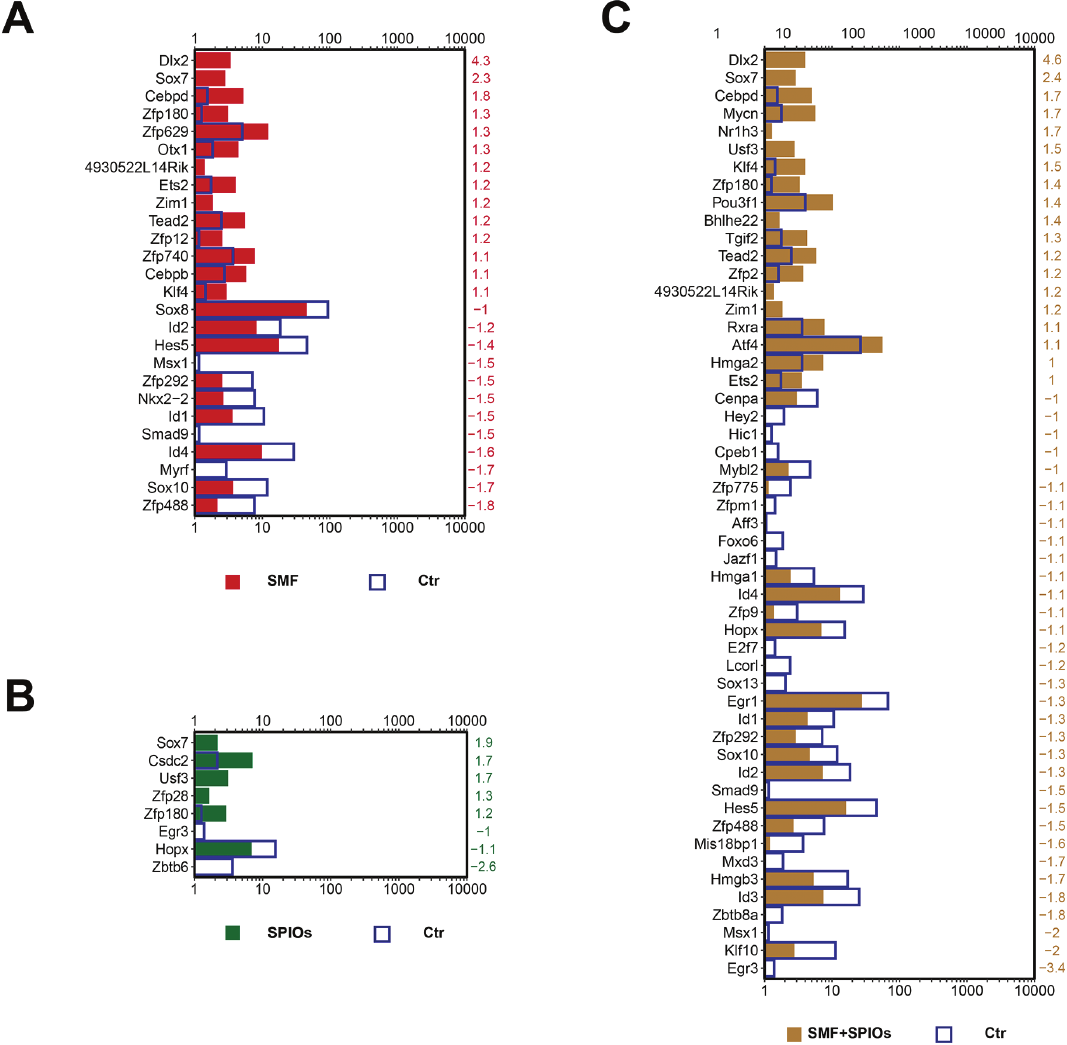
Fig. 5. Transcription factors of NSCs in different culture condition groups. (A) The expression of 26 genes involved in the tran- scription factor of NSCs cultured in SMF group and control group. (B) The expression of eight genes involved in the transcrip- tion factor of NSCs cultured in the SPIOs group and control group. (C) The expression of 52 genes involved in the transcription factor of NSCs cultured in the SMF + SPIOs group and control